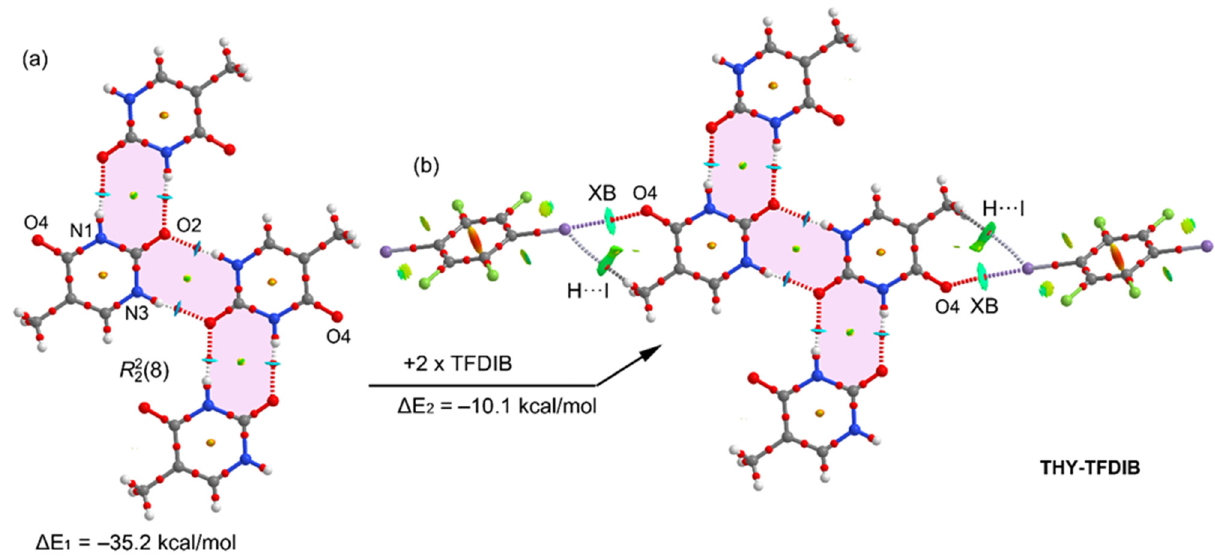
Figure 6. ( a ) QTAIM distribution of bond and ring CPs (red and yellow spheres, respectively) and NCIplot of the R 2 (8) tetramer. ( b ) QTAIM distribution of bond and ring CPs (red and yellow spheres, respectively) and NCIplot of the hexamer of compound THY–TFDIB. The formation energies ( ∆ E) computed at the PBE0-D3/def2-TZVP level of theory are also indicated.